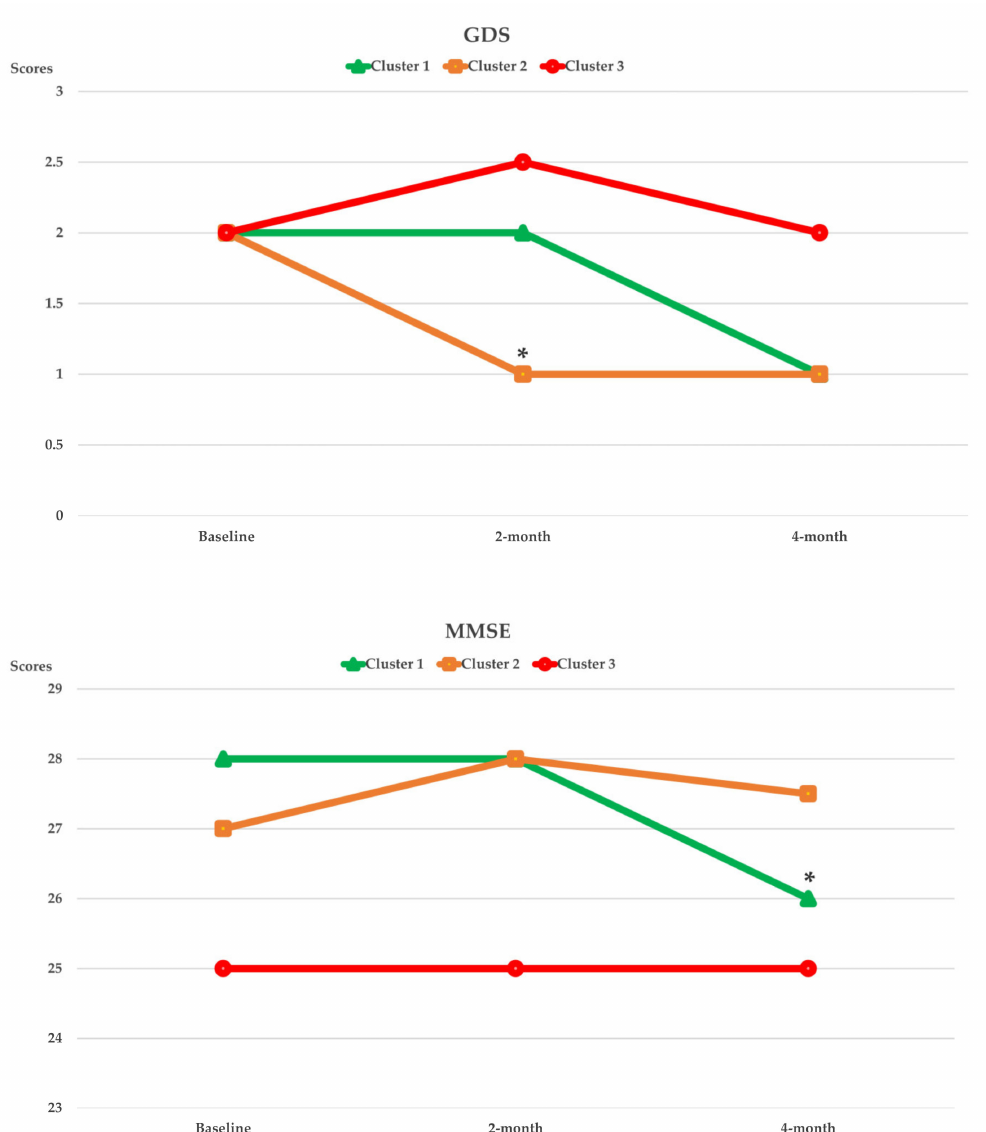
Figure 6. Curve chart for the within cluster comparison of median of intrinsic capacity in cognition and psychological capacity captured by GDS and MMSE at two-month and four-month of inter- vention. * Indicated significant different from baseline, compared by Wilcoxon Signed Rank test; * p < 0.05. GDS, 15-item Geriatric Depression Scale; MMSE, Mini Mental State Examination. The dietary intervention adherence effect on intrinsic capacity is shown in Table 3. After adjusting for covariates, significant interaction effects between higher dietary in- tervention compliance and time were observed in TMS ( p interaction = 0.009) and MMSE ( p interaction = 0.022). Significant cluster effects were observed in GS ( p clusters = 0.034) and TMS ( p clusters = 0.010). Significant time effects were observed in CST ( p time < 0.001), TMS ( p time = 0.031), and MMSE ( p time = 0.022). After four months of intervention, ADL signif- icantly improved among participants who were highly adhered to dietary intervention ( p interaction = 0.034; Table